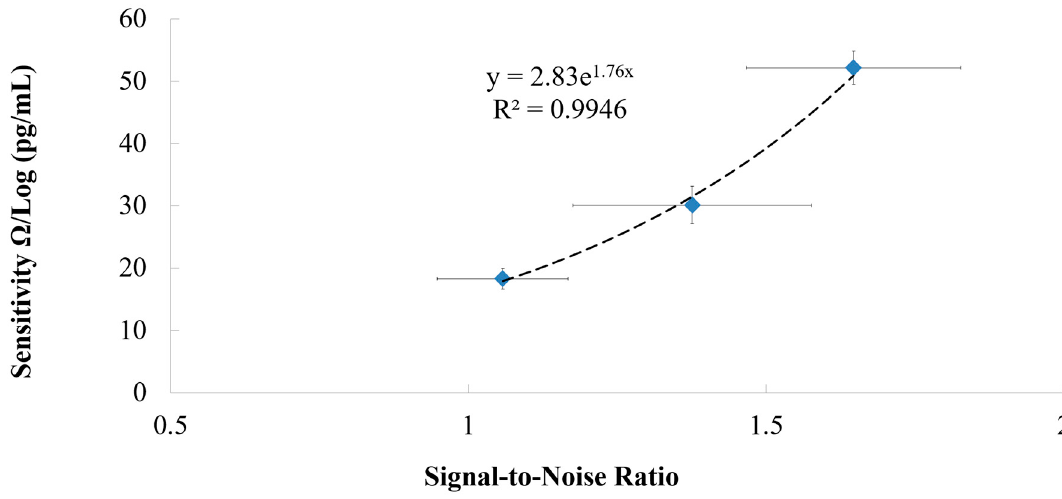
Figure 13. The relationship between the sensitivity and the signal-to-noise ratio of the immunosensor.